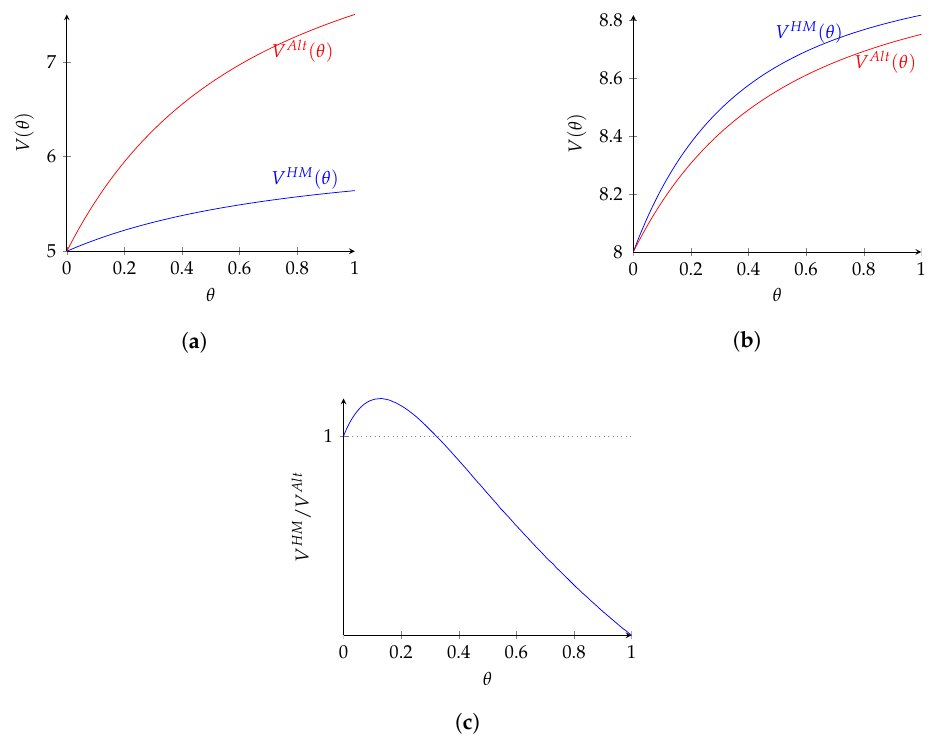
Figure 2a: Comparing principal’s profits for p 2